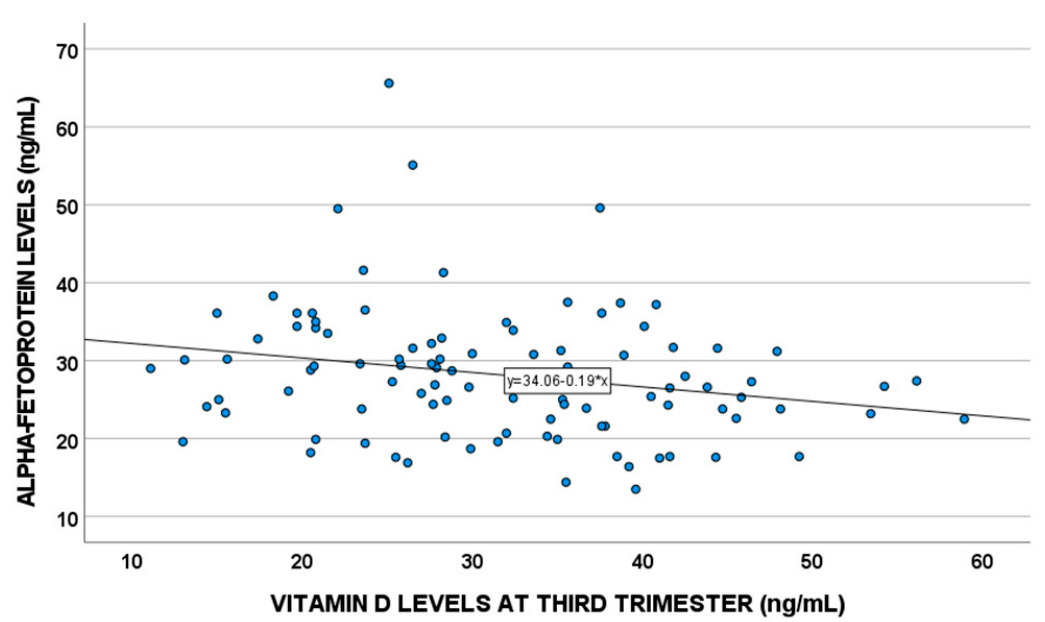
Figure 2. Vitamin D levels and alpha-fetoprotein correlation ( p = 0.02, SC = − 0.24).